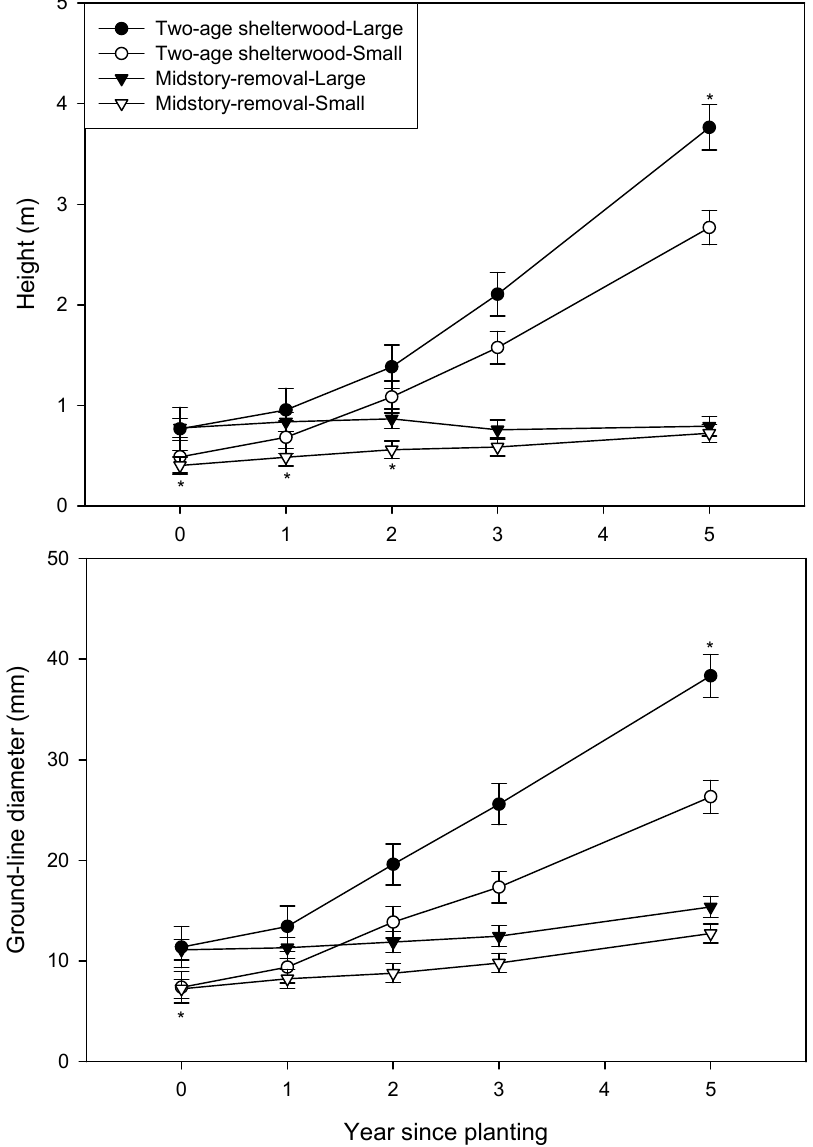
treatment (Figure 2). Figure 2. Height and ground-line diameter with associated standard error bars for five years after planting American chestnuts in two silvicultural treatments for two seedling size class groups. Asterisks, positioned above the two-age shelterwood lines or below the midstory-removal lines, indicate significant differences between the two size classes within year and silvicultural